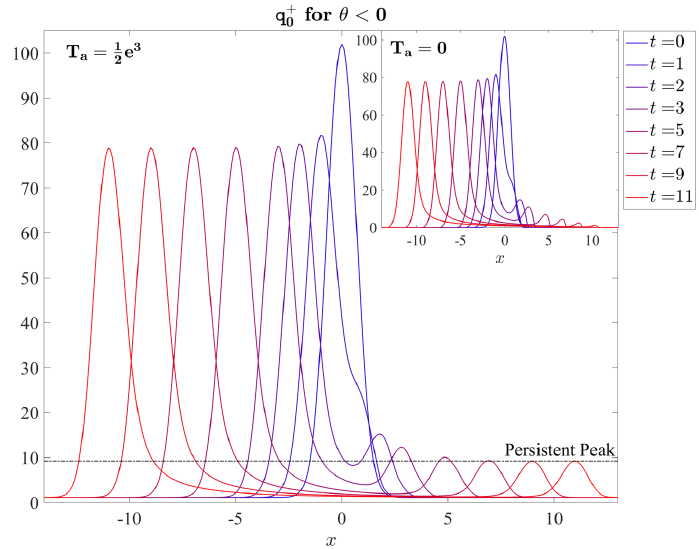
p x , t q obtained from integrating 0